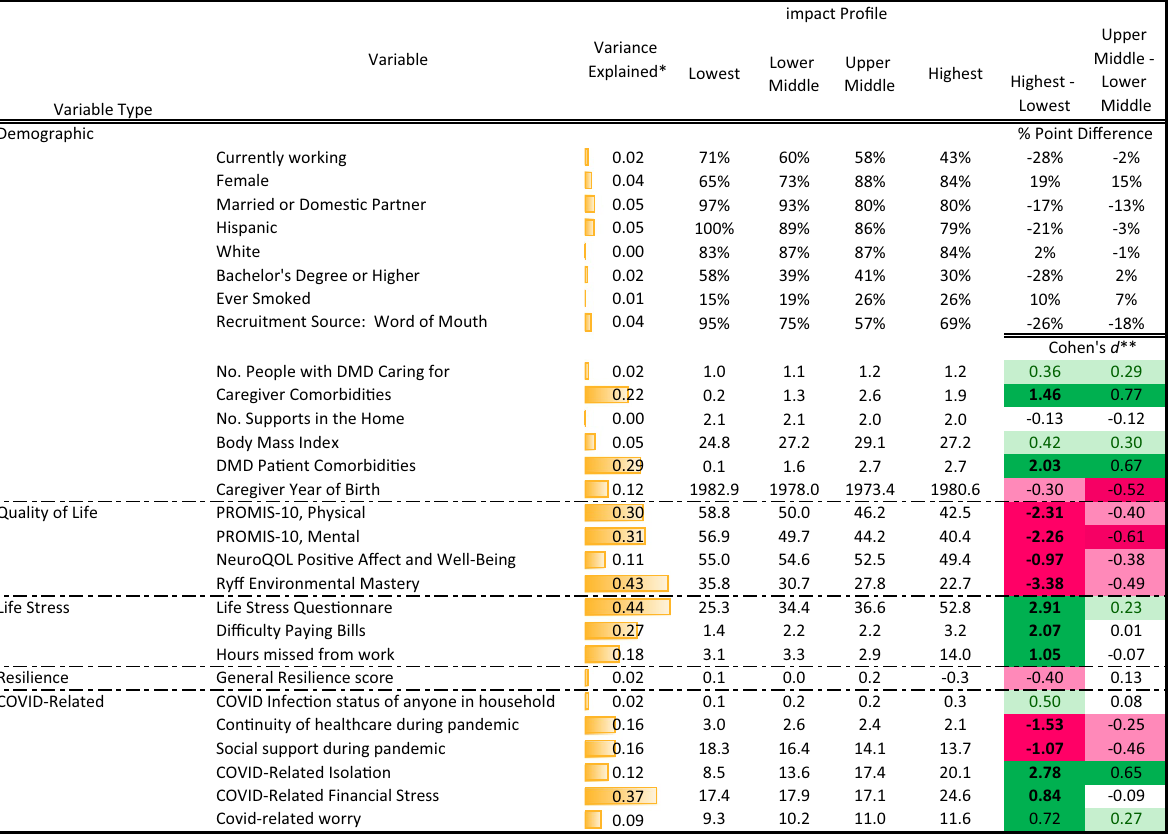
Table 2 Demographic, quality of life, and stress differences by latent profile group